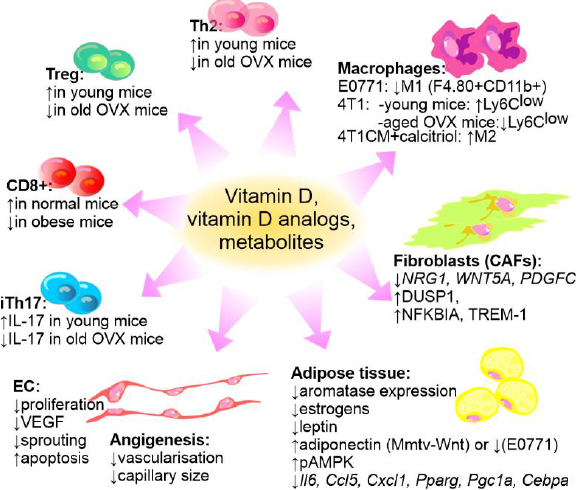
Figure 6. Summary of the effects of vitamin D on various cells in tumor microenvironment and on immune system in breast cancer. CAFs — cancer-associated fibroblasts, iTh17 — induced Th17, EC — endothelial cell, Treg — regulatory T lymphocytes, CD8 + — CD8 + T lymphocytes, Ly6C — lymphocyte